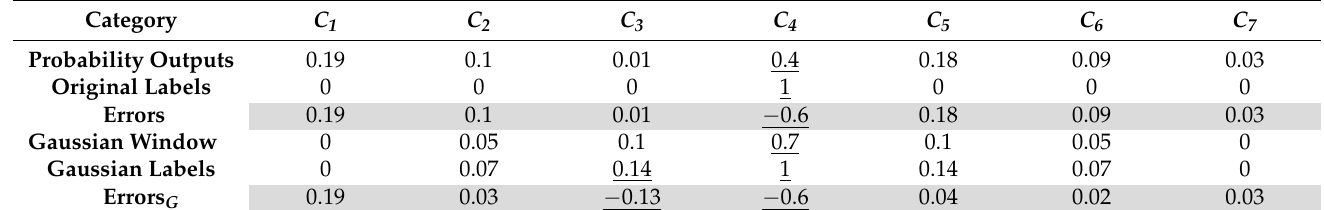
Table 1. An example of using Gaussian labels. There are seven categories ( C 1 to C 7 ), a probability vector, original labels, original labels’ errors, Gaussian windows ( µ = 4, and σ = 0.5), Gaussian processed labels ( µ = 4, and σ = 0.5), and Gaussian processed labels’